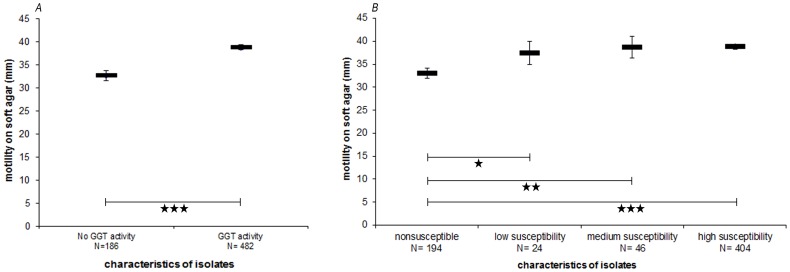
Mean motility of C. jejuni differed significantly between isolates with diverging GGT activity and susceptibility.Motility was tested on semisolid agar inoculating drops of 1 µl McFarland 3 (approx. log10 8 cfu/ml) suspension. Differences of p<0.05 were considered as significant. Stars on vertical lines represent level of significance (***:P<0.0001; **:P<0.001; *:P<0.05). Error bars represent standard error of the mean. (A) Comparison of mean motility in isolates with and without GGT activity (B) Comparison of mean motility of isolates exibiting different phage susceptibility classes.